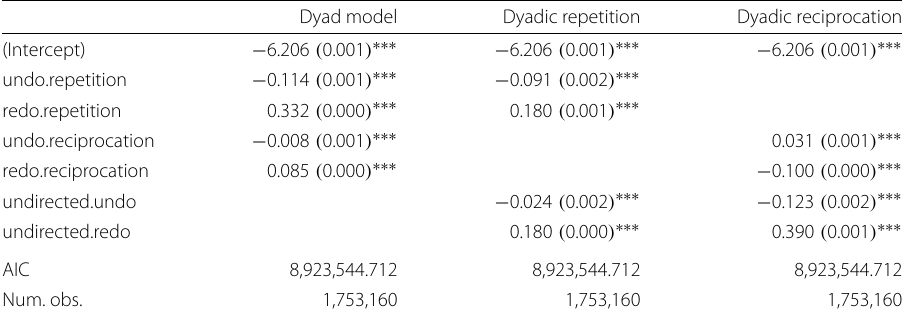
Table 4 Explaining dyadic redo by past dyadic undo and past dyadic redo on the same dyad Dyad model Dyadic repetition Dyadic reciprocation